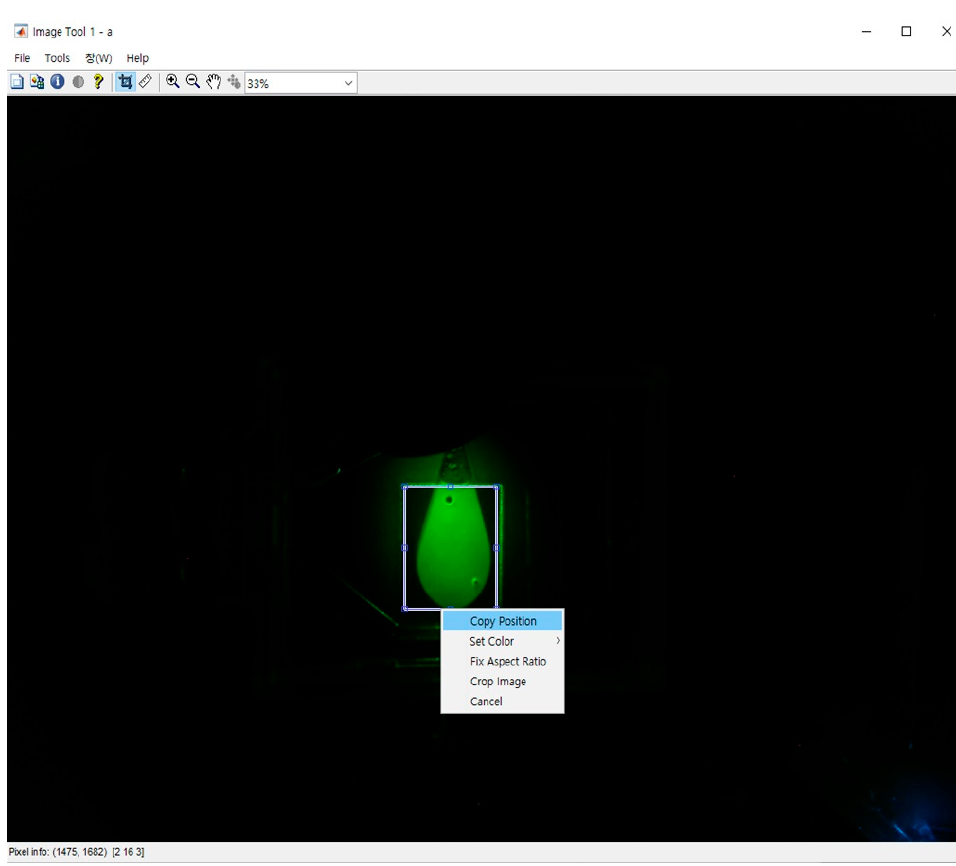
Figure 4. Region of interest (ROI) selection for image processing.